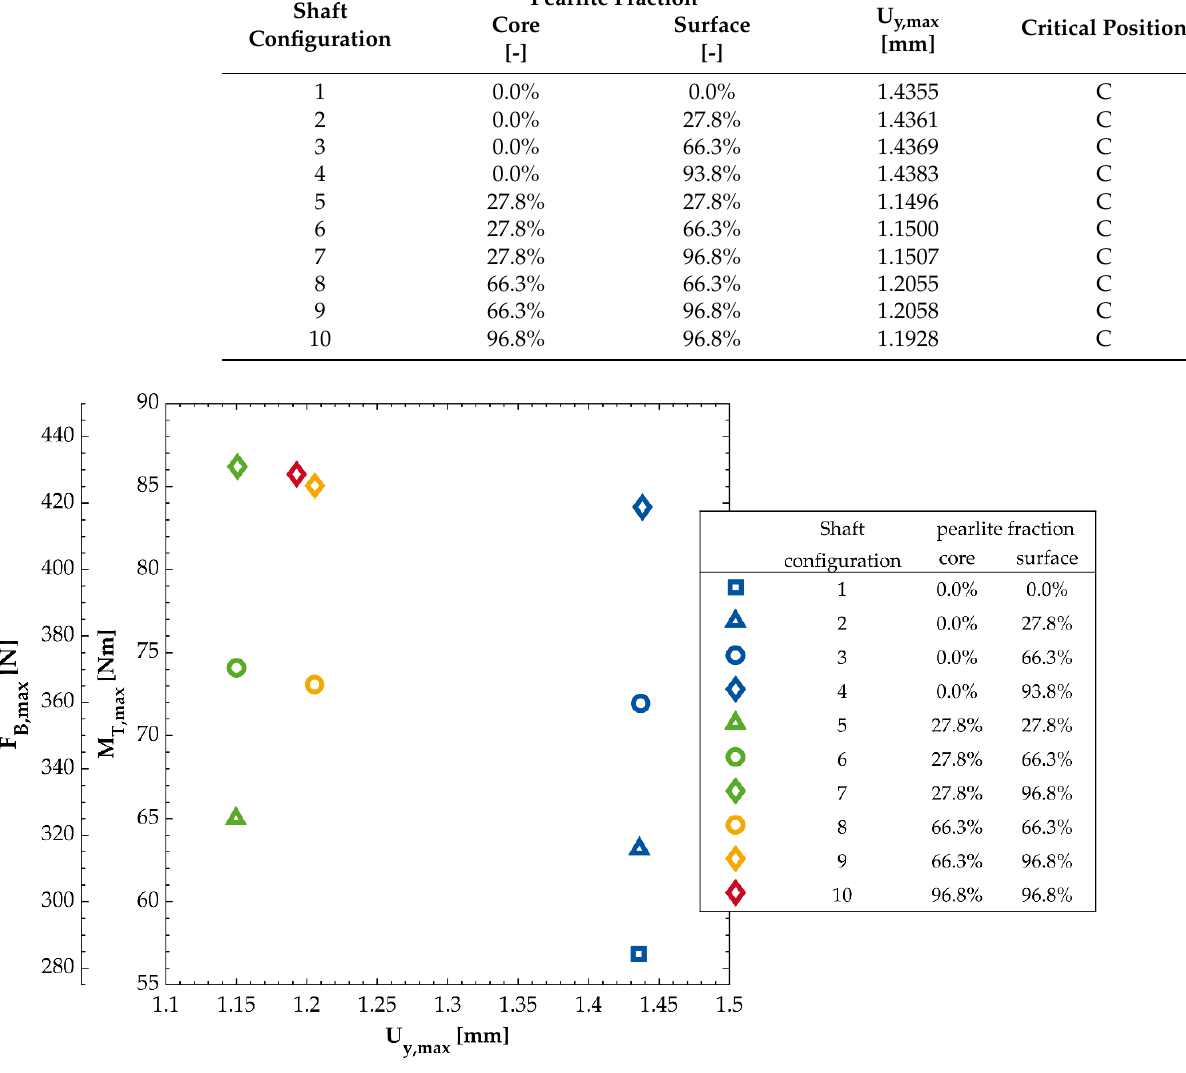
Figure 7. Calculated permissible static bending displacements U y,max as well as cyclic torsional moments M T,max and bending Forces F B,max for each shaft configuration. The individual configurations differ by the concentration of pearlite in the matrix of the core material and the surface layer of the